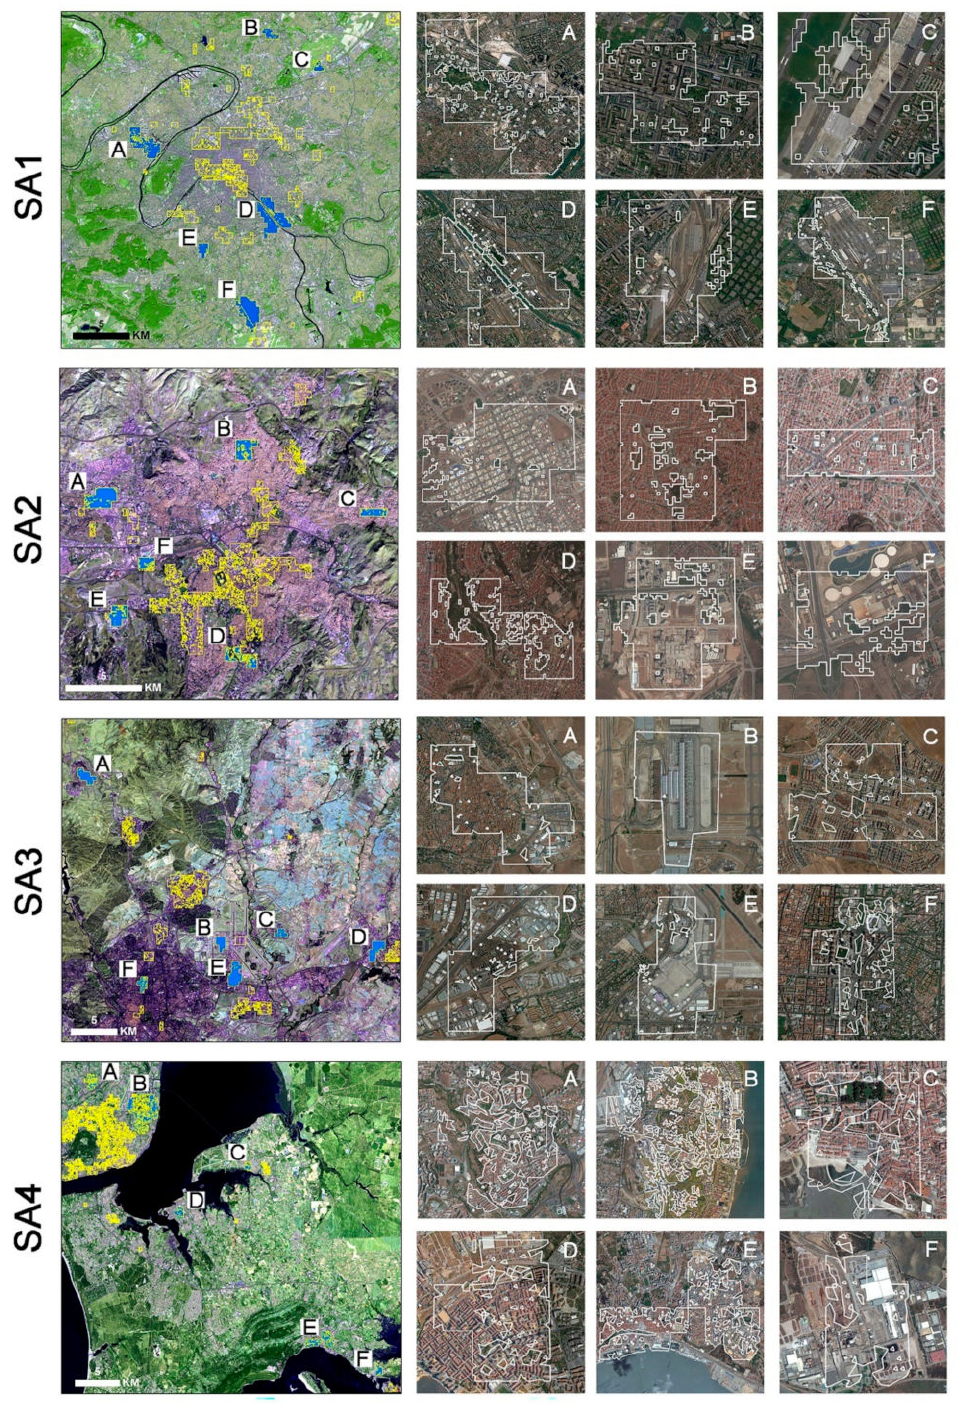
Figure 8. Distribution map of built-up area sample sites. The yellow polygonal areas represent the built-up area sample sites automatically selected by our method. Six built-up area sample sites (white polygon areas) were selected in the four study areas. Figure 8A–F show the results of superimposing built-up area sample sites onto Google Earth high-resolution remote-sensing